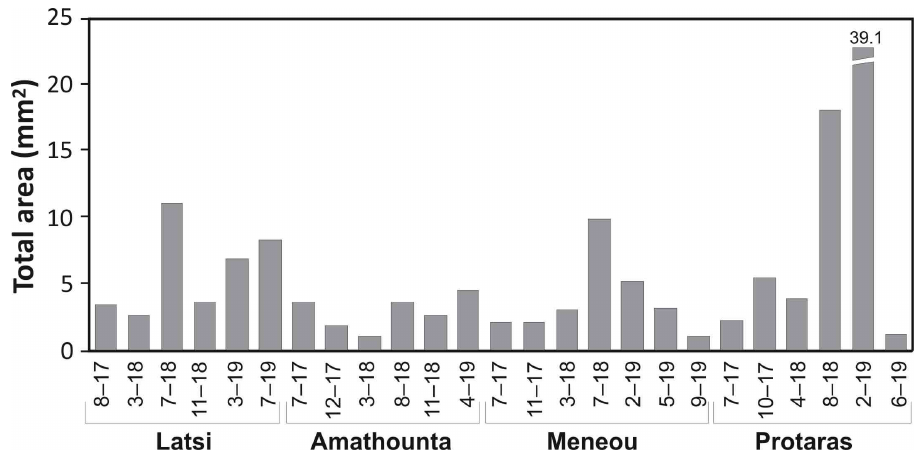
Figure 6. The calculated area (as mm 2 ) of the total number of microplastic fragments found in each of the 25 samples in the four sampling areas (Latsi, Amathounta, Meneou and Protaras) during the years 2017–2019. (In each sample, the first number refers to the sampling month and the last two numbers to the sampling year.)